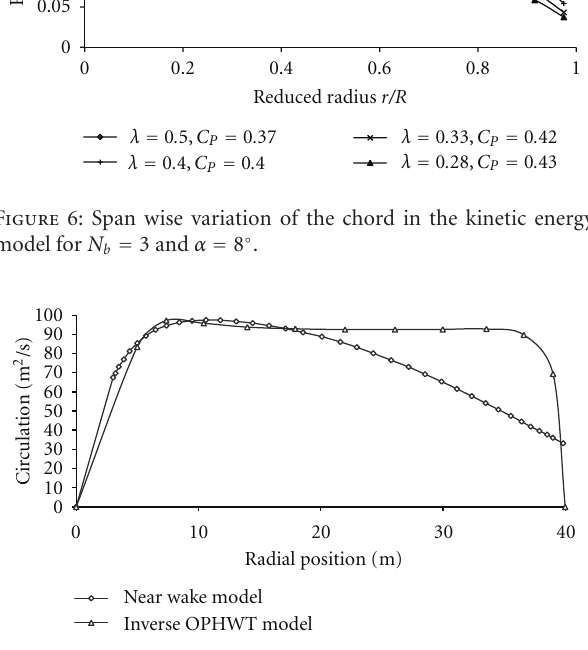
Figure 7: Comparison of the circulation Γ (m 2 /s) between the in- verse OPHWT model and the near wake model for the 40 m rotating blade at a free wind speed of 7ms − 1 and for C p = 0 . 48.